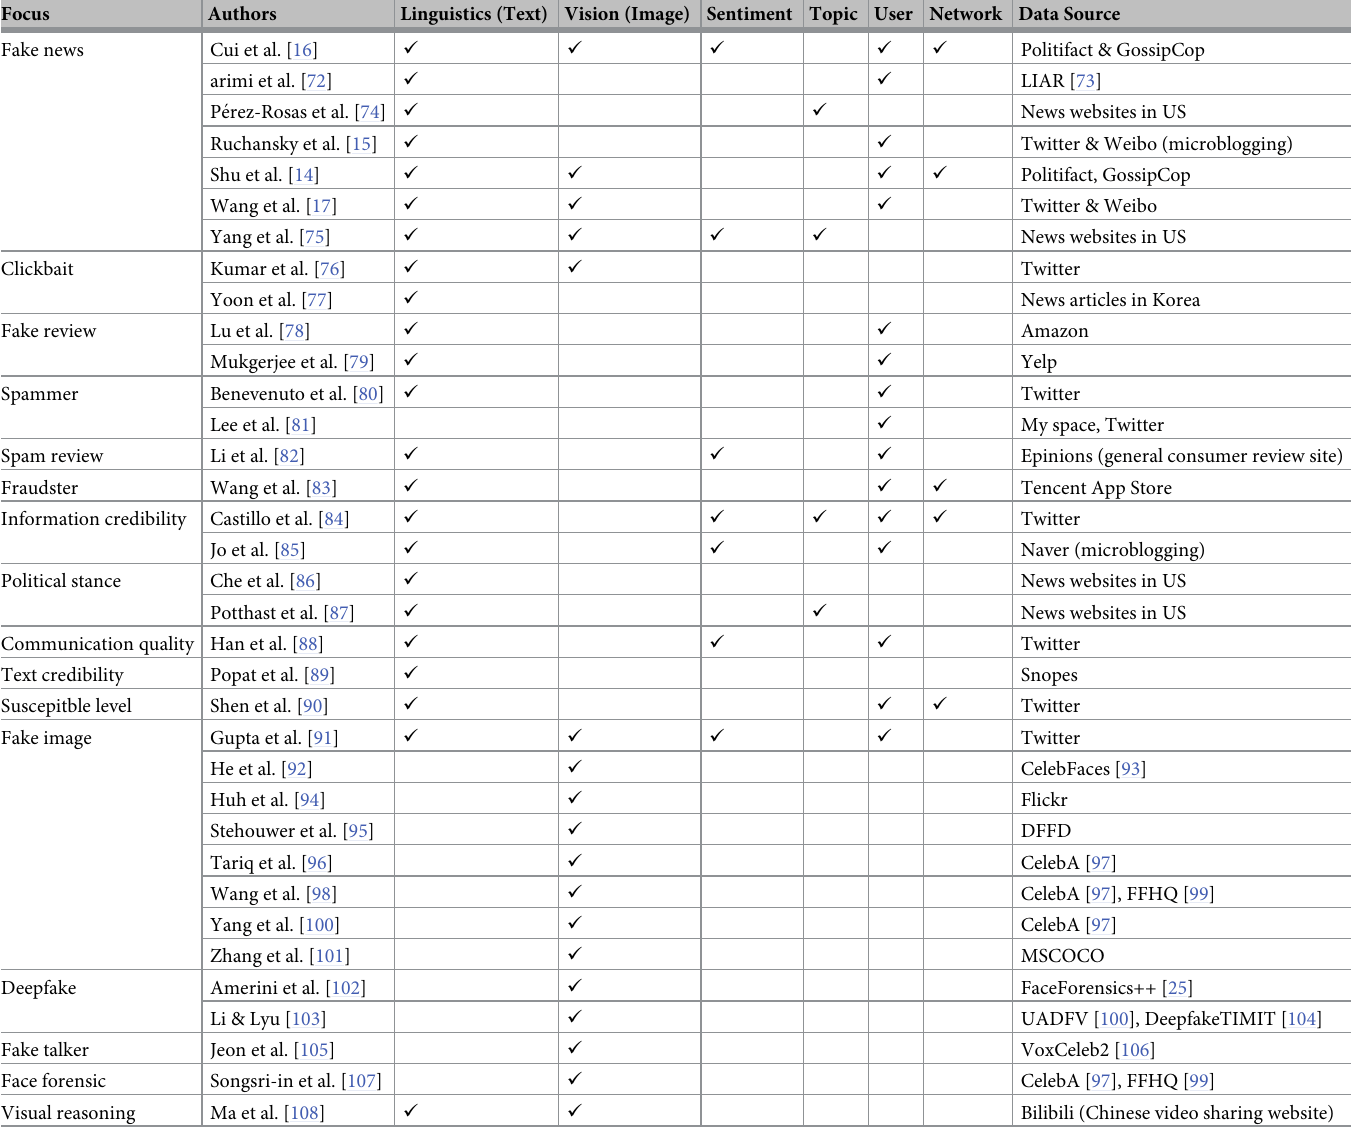
Table 1. Examples of the prior research on fake information and visual media detection